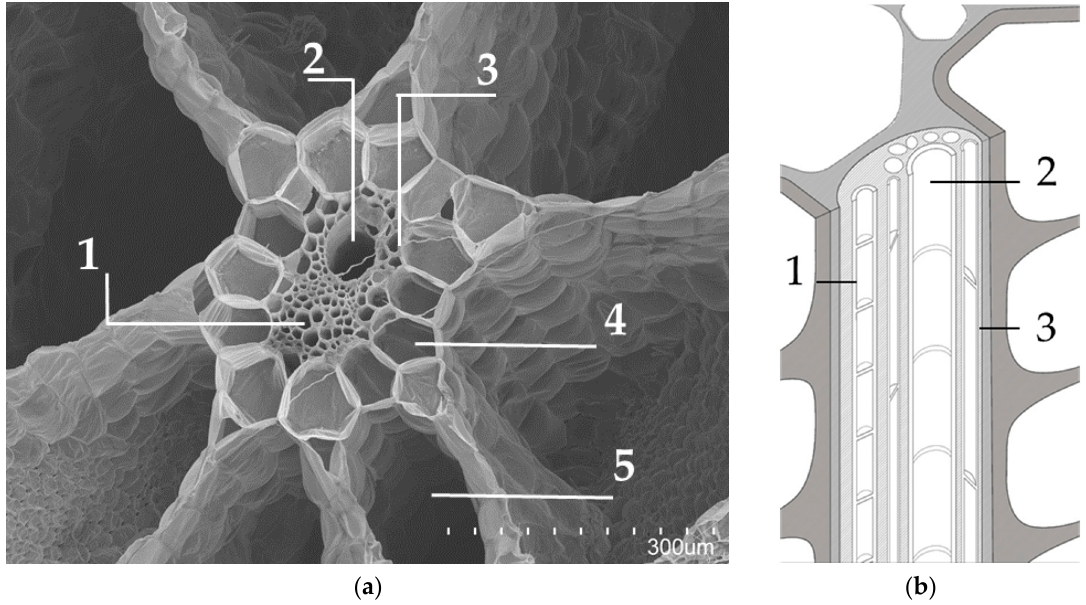
Figure 4. ( a ) Internal structure of the “ fibre unit” of the petiole section, SEM view . “ Fibre unit” composed of Vascular bundle (Phloem (1); Xylem (2); Companion cell (3)), surrounded by parenchymatous cells (4) and aerenchyma tissue (5); ( b ) Vascular bundle sketch (Phloem (1); Xylem (2); Companion cell (3)).